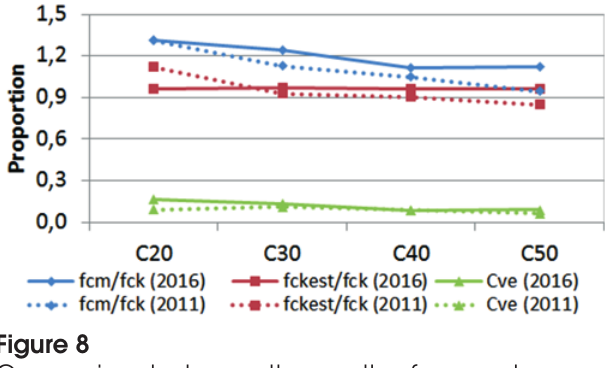
Figure 8 Comparison between the results of concrete produced until 2011 and the results of concrete produced until